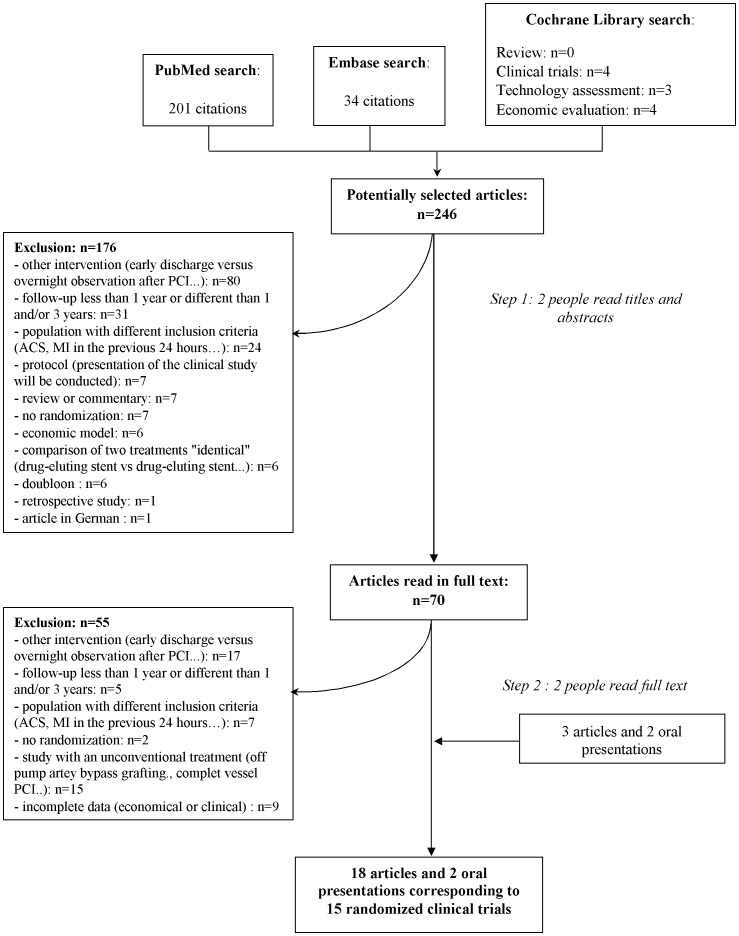
Flow diagram of the screening process.